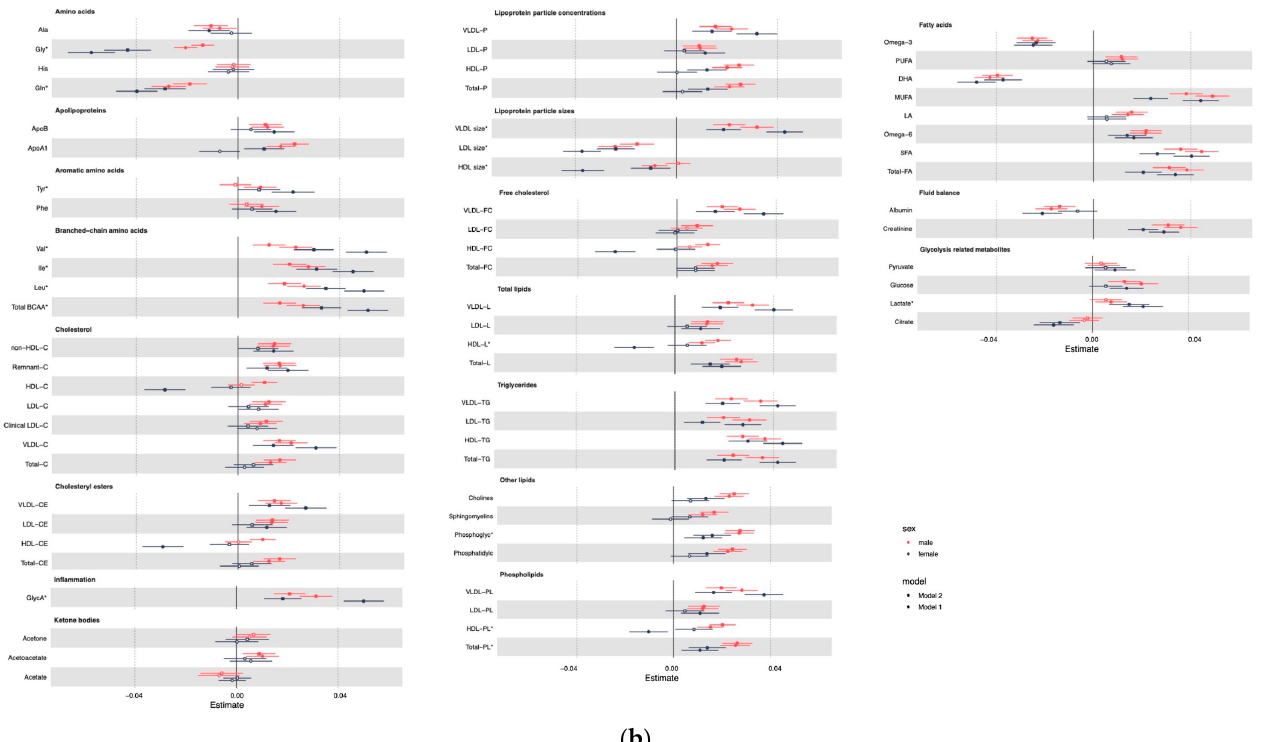
Figure 2. Associations of processed meat consumption with metabolites in men and women. ( a ) Associations with lipid subclasses. ( b ) Associations with other metabolites. Footnote: Mode l adjusted for age at recruitment, ethnicity (White/Asian or Asian British/Black or Black British/Chinese/Mixed/Other), Townsend deprivation Index (TDI), education (with/without university degree), physical activity level (low/moderate/high), smoking status (never/previous/current), alcohol drinking status (never/previous/current); model 2 additionally adjusted for body mass index (BMI). Non-significant associations that did not pass FDR < 5% threshold is shown in hollow dot. Metabolites showing significant sex differences after adjusting for minimally adjusted confounders are indicated with *.